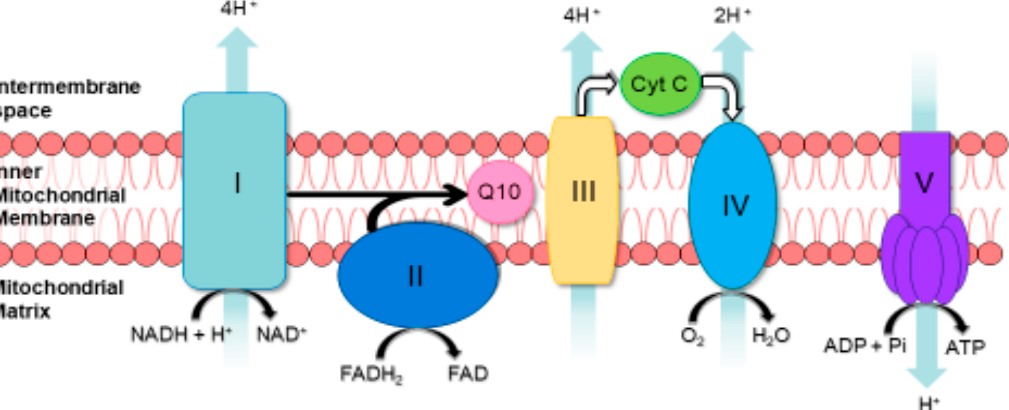
Figure 1. Diagram of the mitochondrial respiratory chain (MRC) and complex V illustrating proton (H+) movement during oxidative phosphorylation. Protons as pumping into the inner mitochondrial space occurs at complexes I, III and IV and the protons pass back into the matrix at complex V. This is known as the `proton circuit` and is illustrated by the arrows in the figure . Q10: Coenzyme Q 10 . Cyt C: Cytochrome c